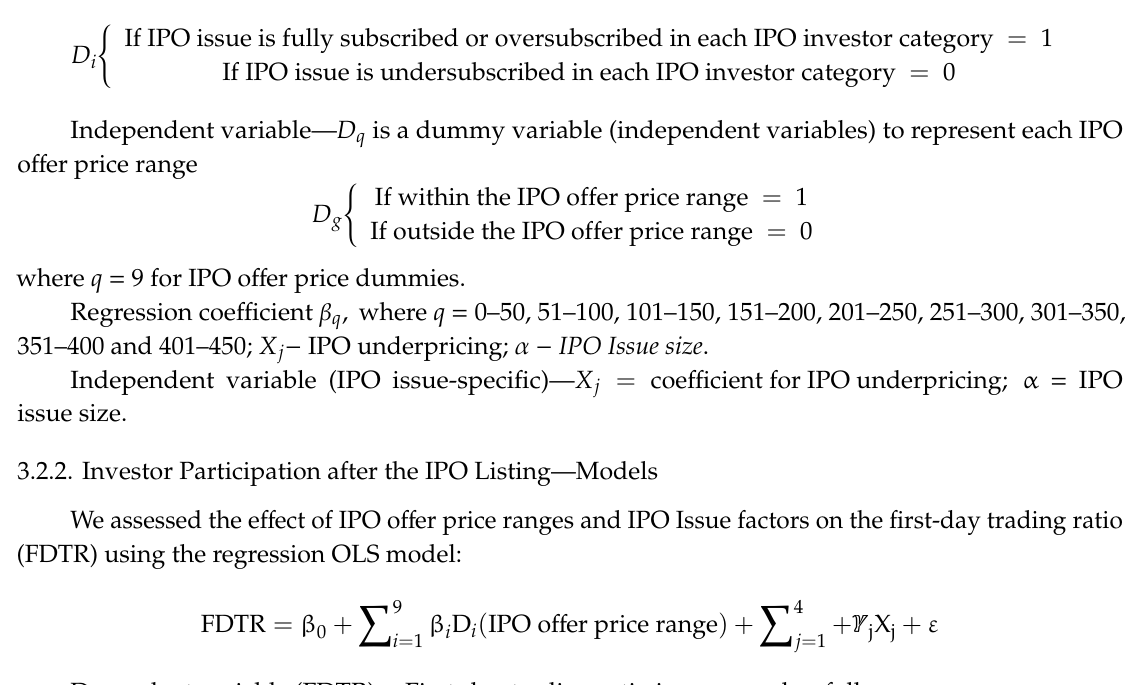
11 of 20 Table 4. Correlation matrix—first-day trading ratio and IPO issue factors. Correlation